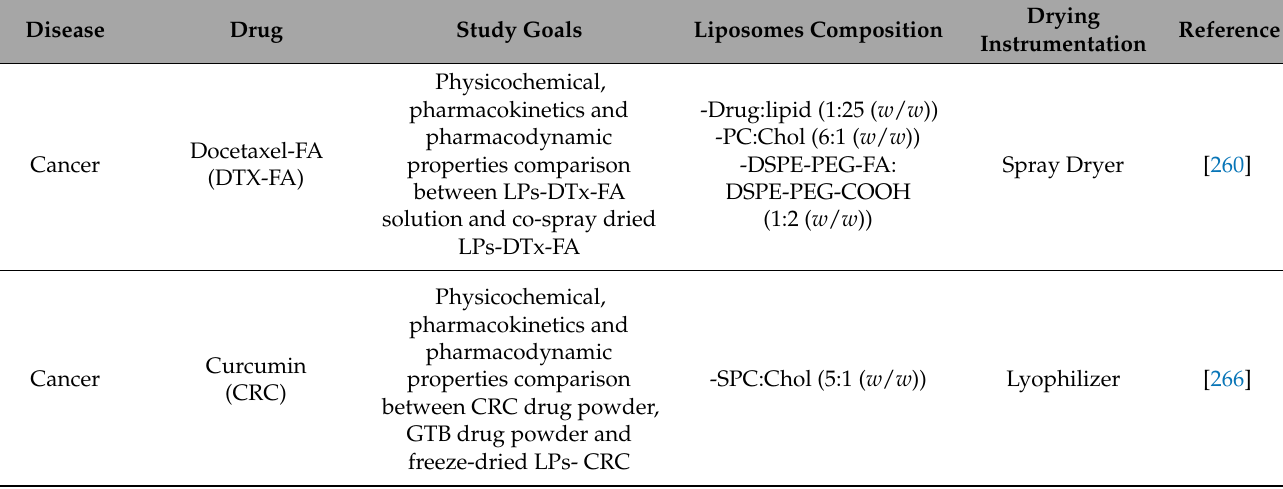
Table 1. Overview of dry powder inhalable LPs (DPI-LPs) formulations evaluated in in vivo experiments.